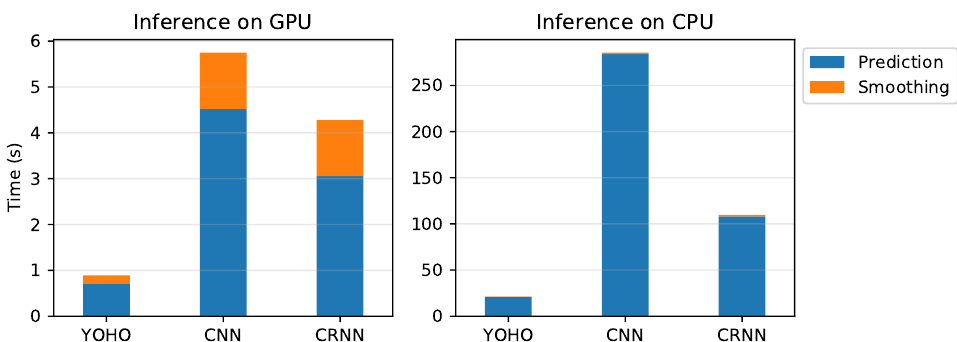
Figure 4. Average time taken to make predictions on 1 h of audio for music-speech detection. ‘Prediction’ refers to the time taken by the network to make predictions. ‘Smoothing’ is the post-processing step to parse the output of the network. The GPU used for inference was the Tesla